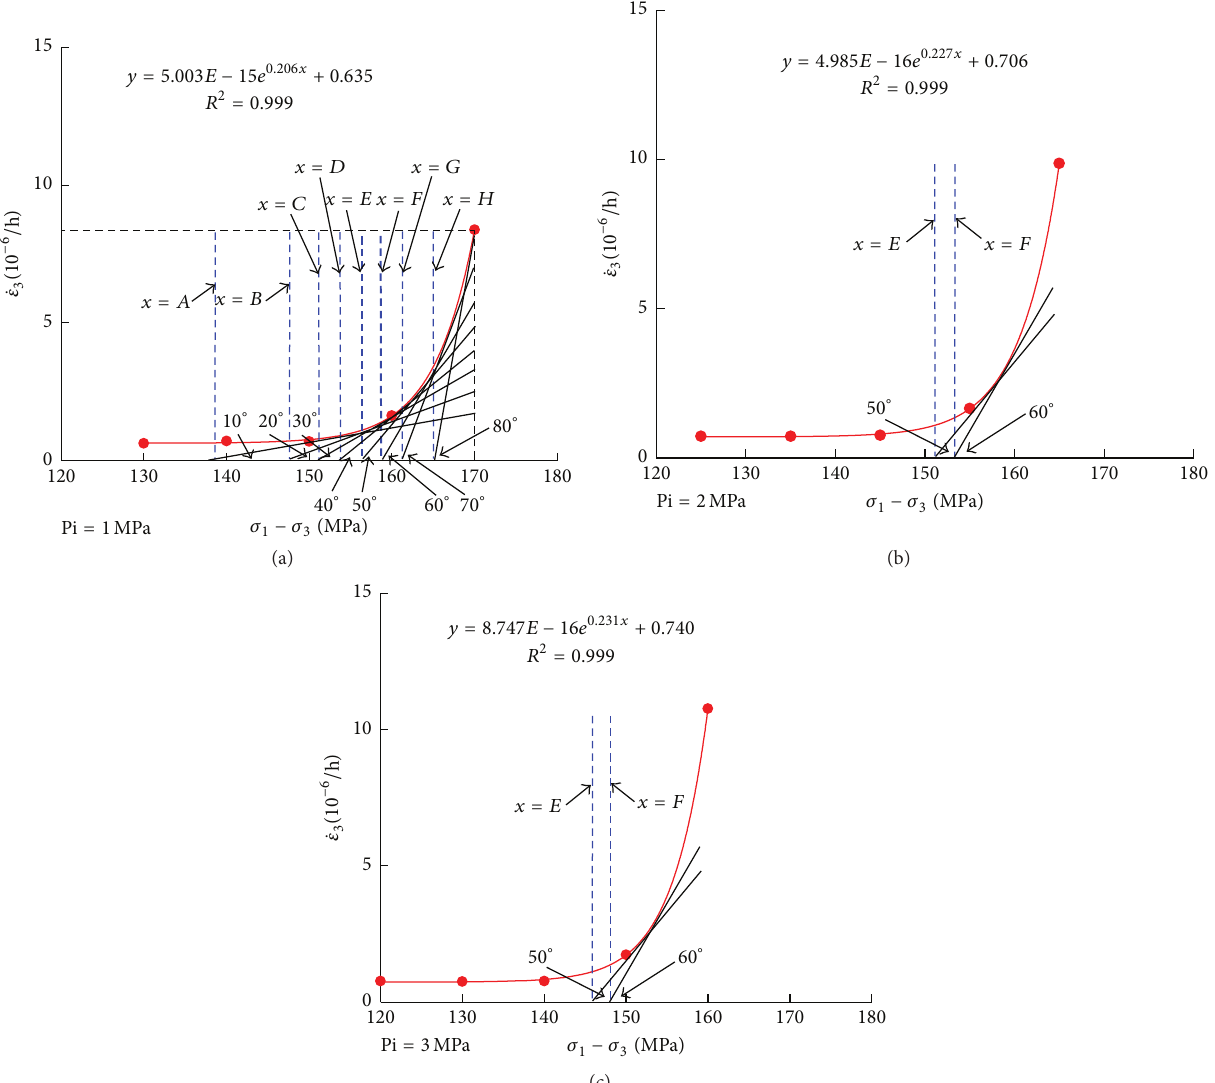
Figure 5: Curves of tangent method of steady creep rate: (a) 𝜎 3 = 4 MPa, Pi = 1MPa; (b) 𝜎 3 = 4 MPa, Pi = 2 MPa; (c) 𝜎 3 = 4 MPa, Pi = 3 MPa.